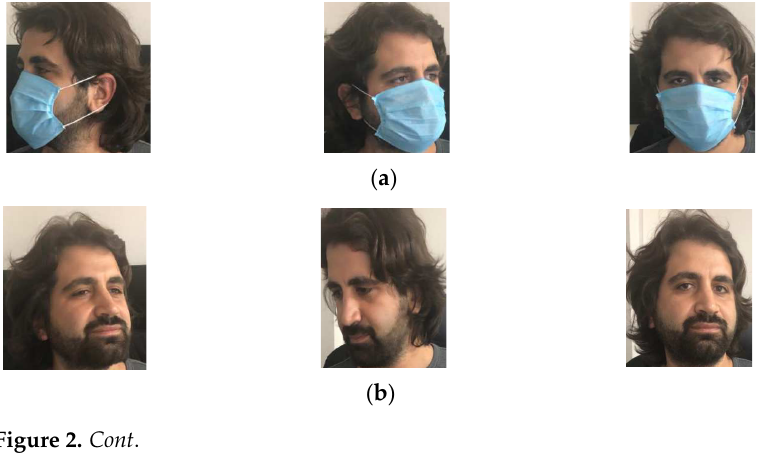
Figure 2. Sample images from the three classes in the dataset: ( a ) mask images, ( b ) no mask images, ( c ) improper mask images. The attributes of the collected face mask dataset are listed in Table 2. Table 2. Amount of class specific data within the dataset. Classes